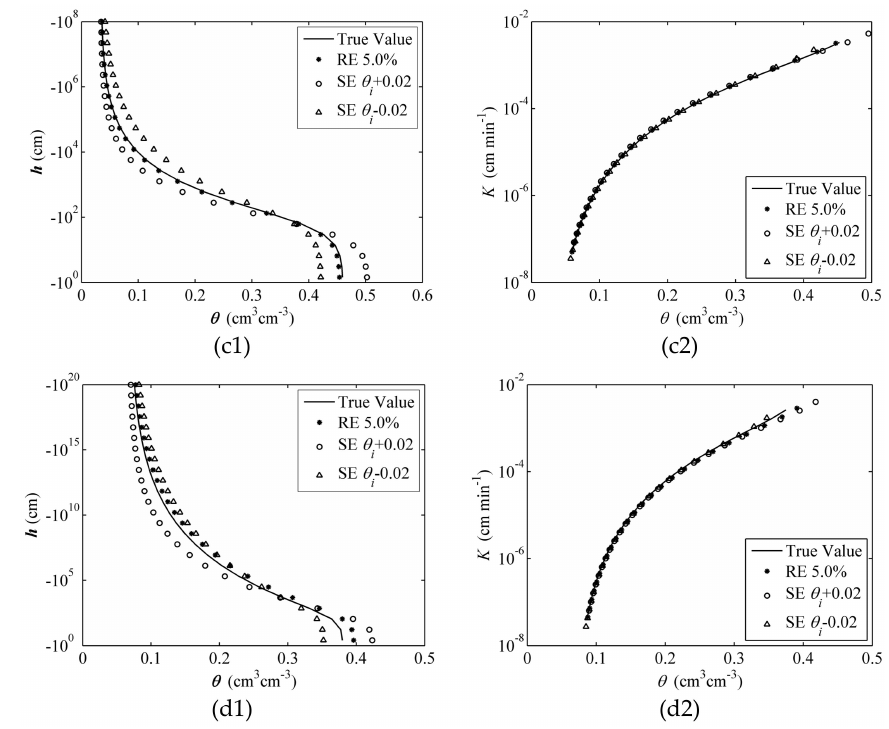
Figure 8. Comparison of SWRCs ( a1 , b1 , c1 , d1 ) and conductivity curves ( a2 , b2 , c2 , d2 ) with random errors (RE) and system errors (SE) for various treatments with objective function ψ ( θ initial ): ( a ) Sand; ( b ) Loam; ( c ) Silt; and ( d ) Clay.